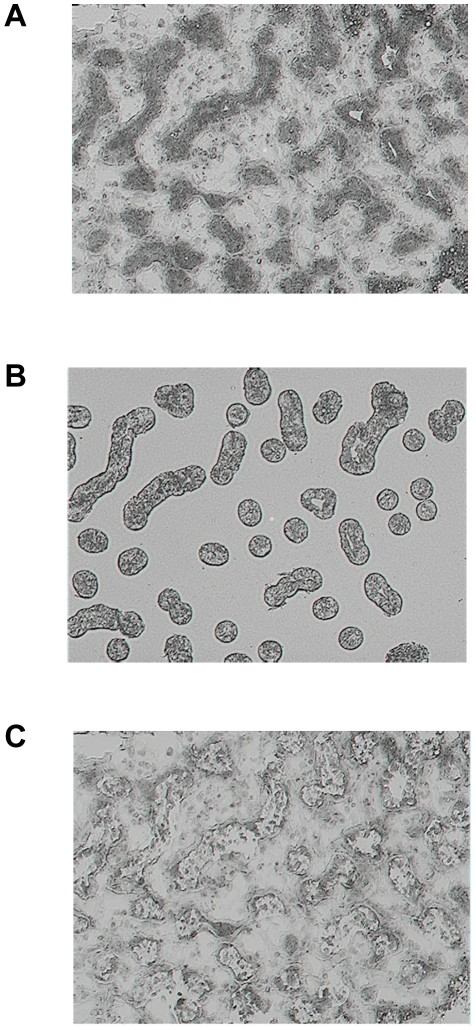
Images of the mammary tissue captured to document cell types captured with laser capture microdissection.Images were captured using light microscopy at 200X A) prior to laser capture microdissection (LCM) B) following LCM and of the C) cap to document populations of epithelial cells isolated from slide.